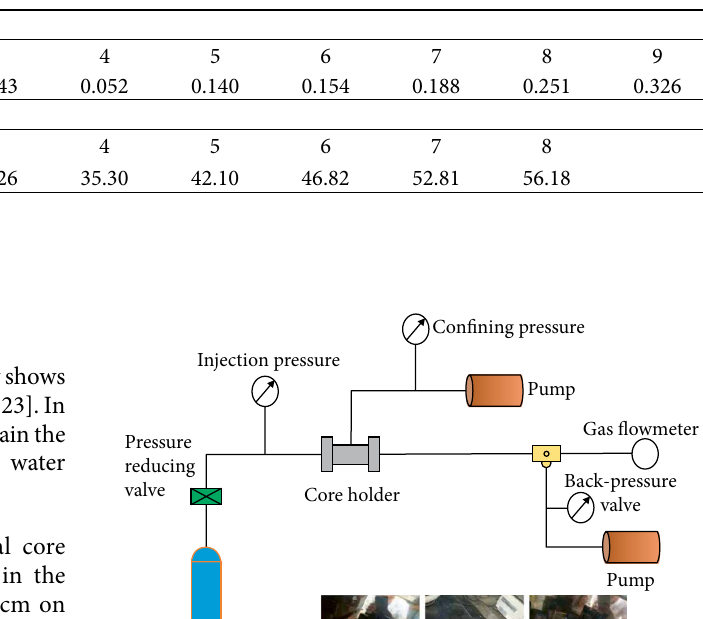
Table 3: The permeability and water saturation of the cores for the two groups of experiments.